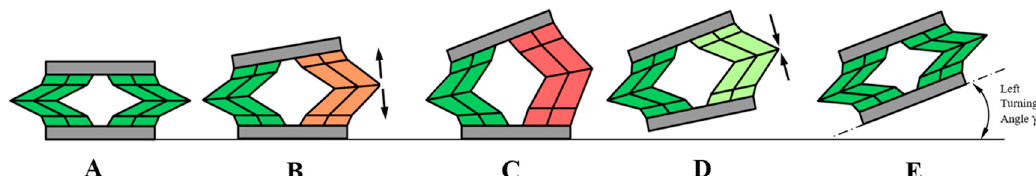
Figure 6. The schematic diagram of the left-turning movement pattern from the top view. ( A ) The folded state of the left and right PFA; ( B ) The unfolding process of the right PFA; ( C ) The unfolded state of the right PFA; ( D ) The folding process of the right PFA; ( E ) The folded state of the right PFA.